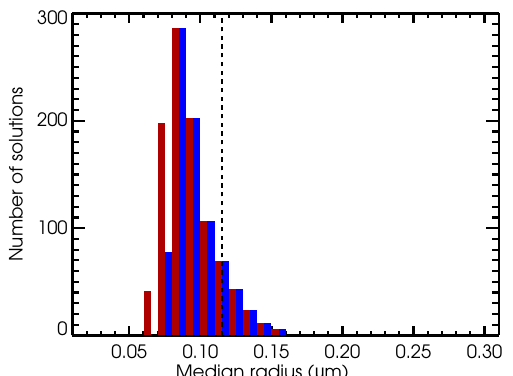
Figure 7. Histograms showing the median radius for all solutions in the gridded LUT that match the backscatter and extinction coef- ficients of Case 1 within measurement errors of 5% for backscatter and 20% for extinction. The dashed line indicates the median radius for Case 1. Red and blue are as in Fig. 6.